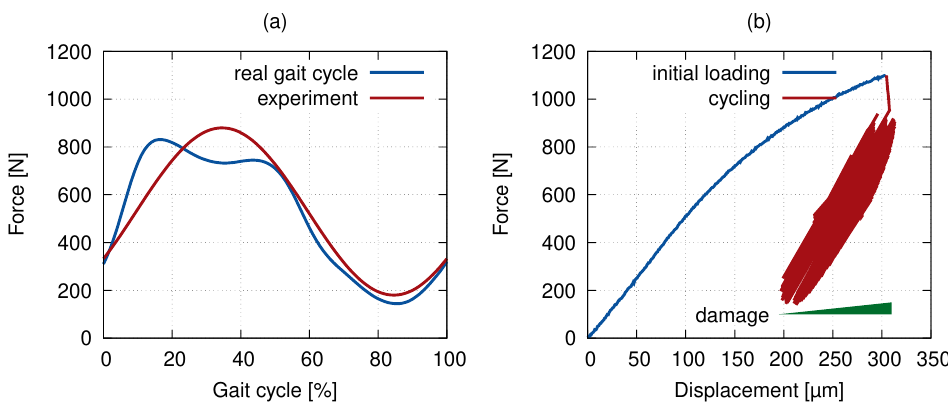
Figure 3. In situ loading: ( a ) the loading function used in the experiment and a real gait cycle and ( b ) the force–displacement curve of the actual loading in the computed tomography (CT)